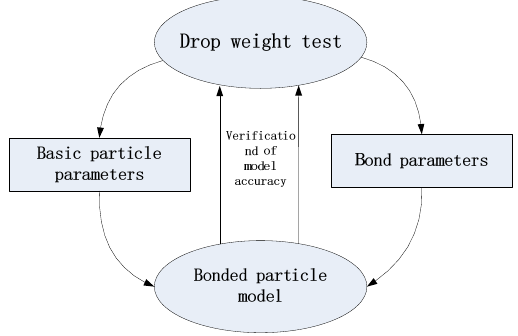
Figure 3. Research method.